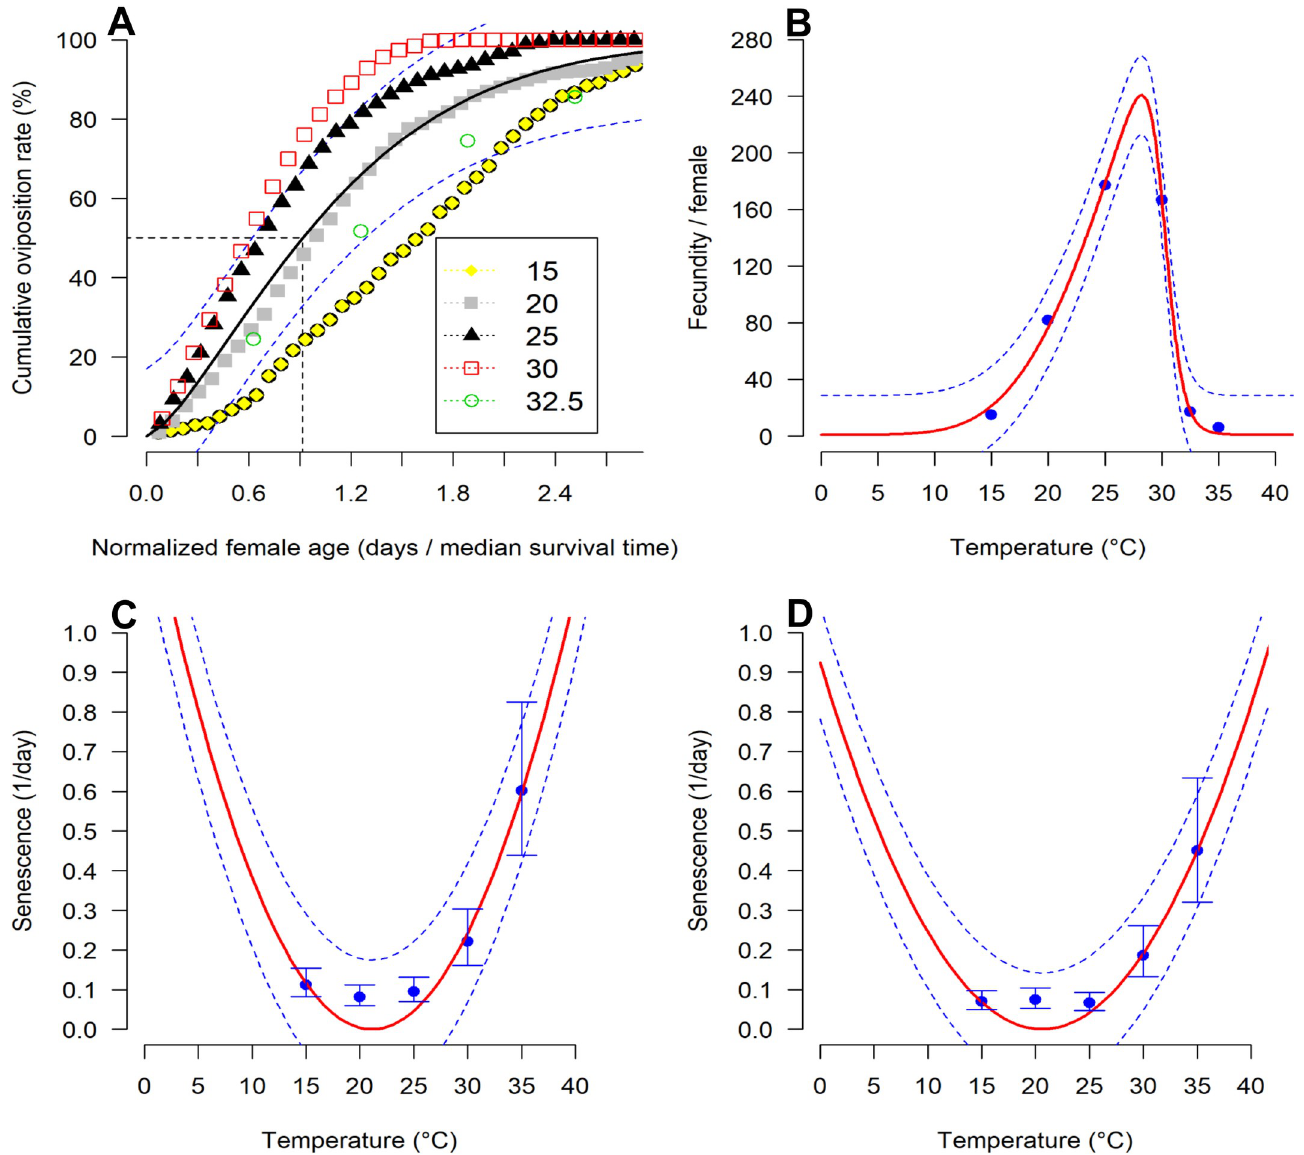
Fig 2. Model fitting to the relationship between fecundity in Diachasmimorpha longicaudata female and temperature, and adult senescence and temperature: (A) cumulative oviposition fitted to exponential modified 3 function; (B) Number of eggs per female fitted to Wang function7; (C) female senescence rates fitted to Ratkowsky function 4 model and D) male senescence rates fitted to Ratkowsky model. The observed experimental values are represented in blue points with bars representing the standard deviation. The solid red lines are the fitted models with dashed lines in blue above and below representing the upper and lower 95% confidence